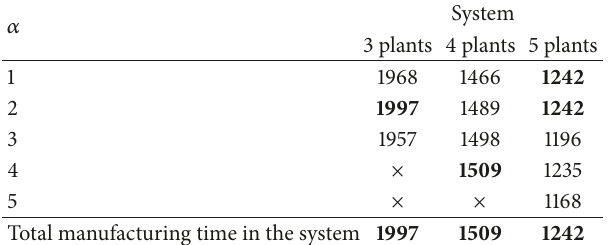
Table 2: Manufacturing times in autonomous systems. Table 3: Time scheduling in case of implementing the time minimisation